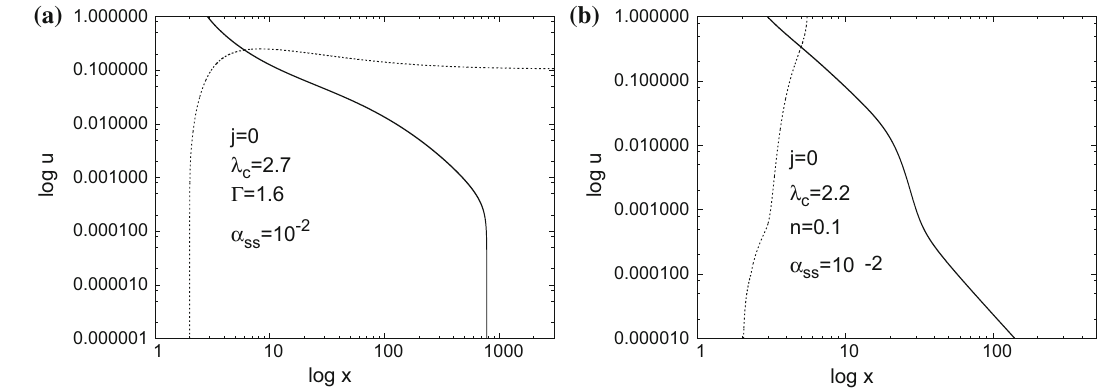
Fig. 3 a , b are plots of log( u ) vs log( x ) for viscous ( α ss = 10 − 2 ) accretion disc flow around a non-rotating BH for adiabatic and MCG, respectively. Accretion and wind curves are depicted by solid and dotted lines respectively